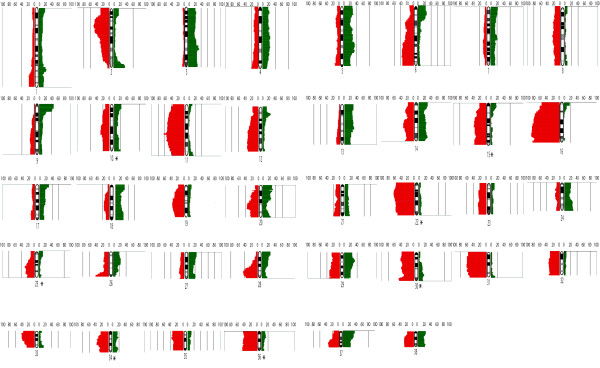
Whole genome CNA penetrance plot showing the percentage of all HS cases in the cohort (BMD+FCR; n = 86 cases) that presented with detectable DNA copy number gain (green) and loss (red) along the length of each dog chromosome (CFA 1 to CFA 38), surveyed at 1 Mb intervals. The asterisks indicate those seven chromosomes (CFA 10, 15, 22, 25, 30, 35 and 36) that have regions of CNAs differing significantly between BMD and FCR.